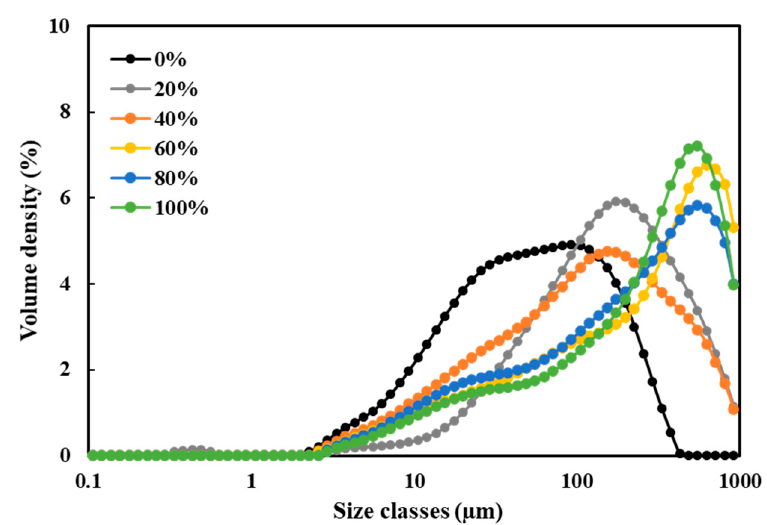
Figure 6. The particle size distribution of 1% ( w / v ) soy protein concentrate (SPC) dispersions determined by a Mastersizer.